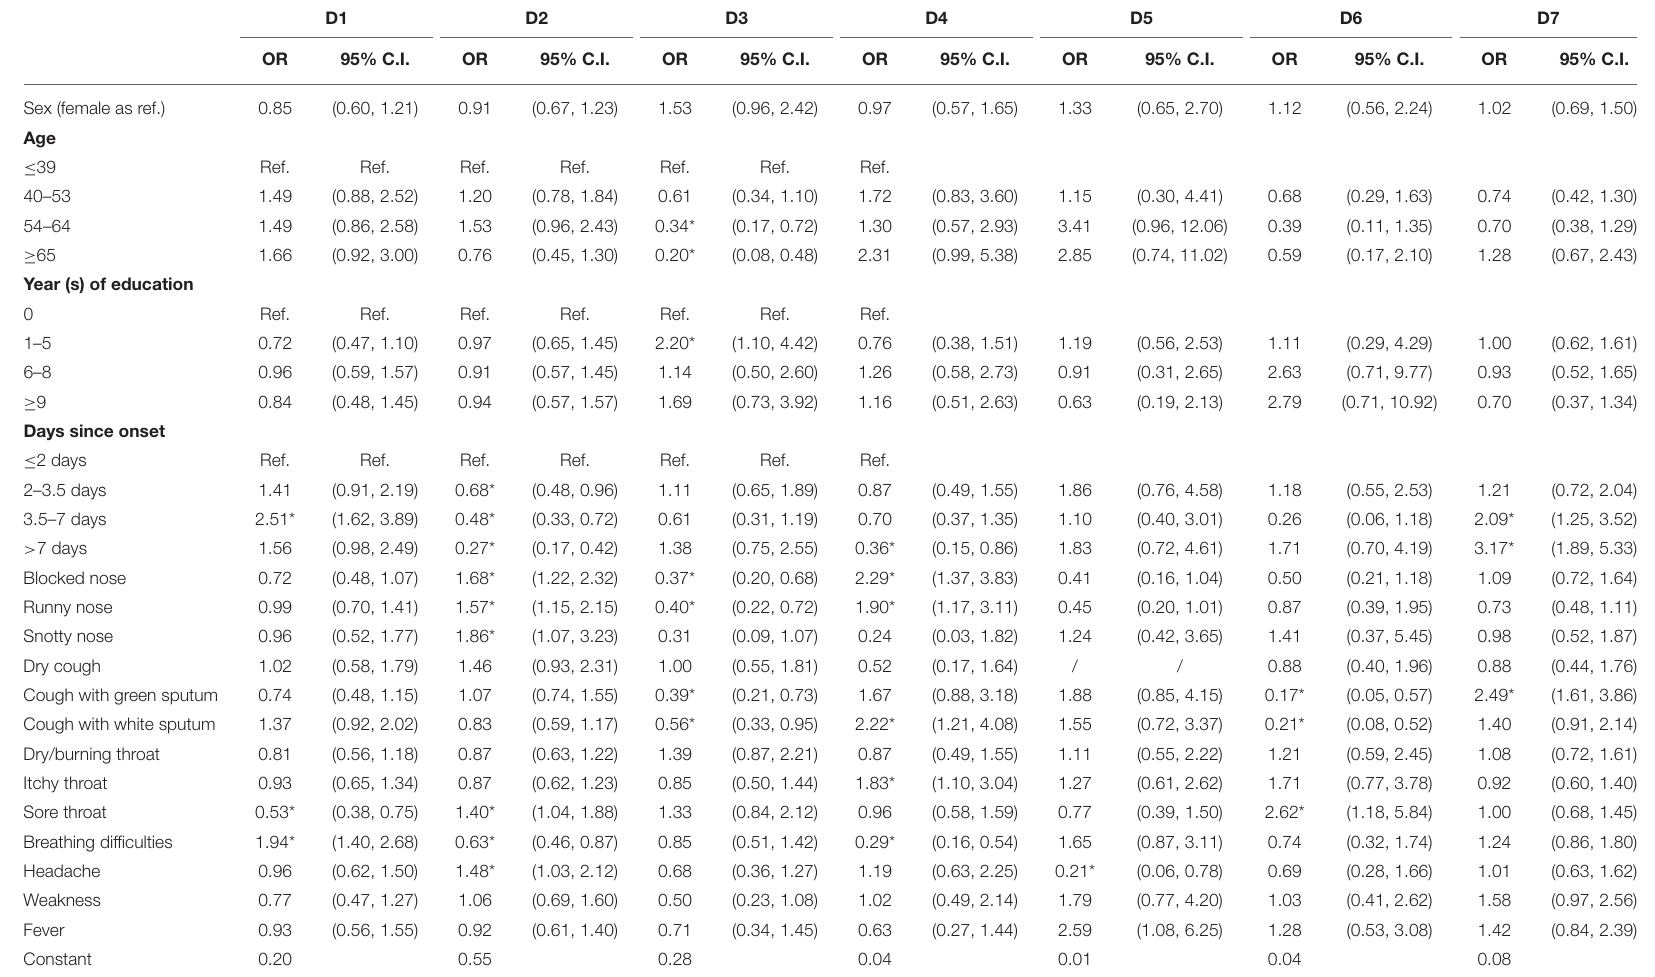
TABLE 3 | Multivariable logistic regression statistics between diagnosis and common